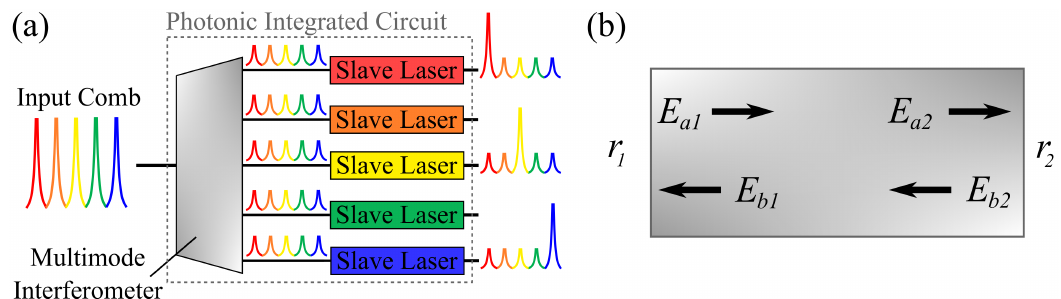
Figure 1. ( a ) Illustration of a photonic integrated circuit for demultiplexing optical combs. The comb is first split equally using a multimode interferometer, and then, individual slave lasers are frequency locked to specific lines in the comb. ( b ) Illustrations of the fields inside a laser cavity, with reflecting mirrors r 1 and r 2